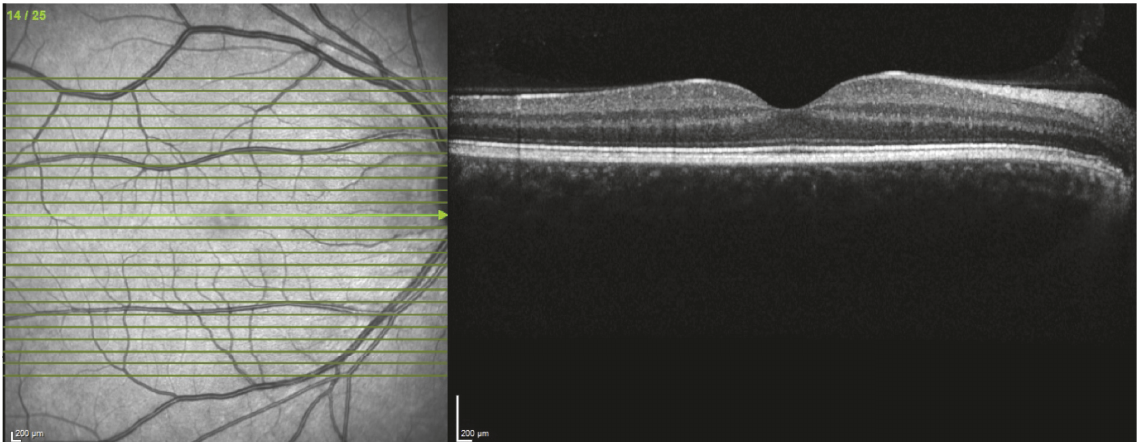
Figure 7: Optical coherence tomography and infrared imaging of the right eye.